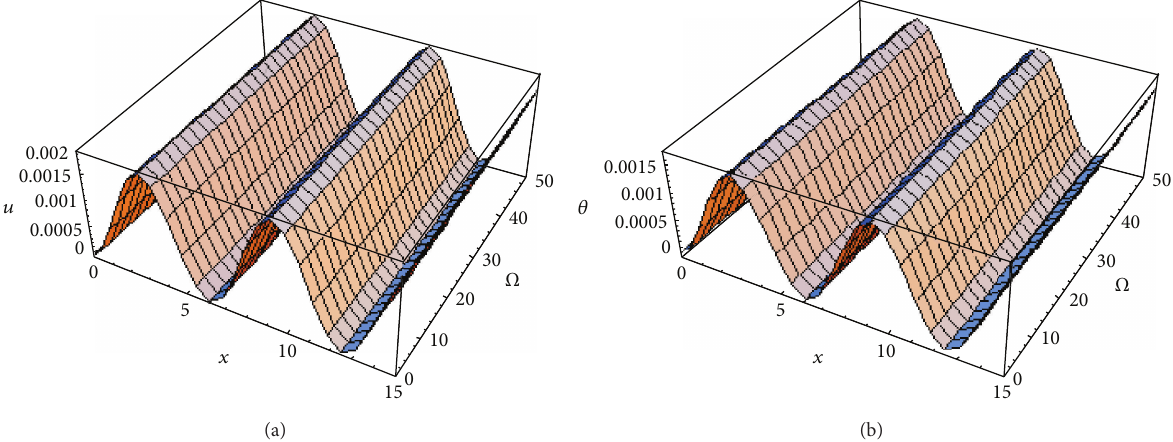
Figure 9: Variations of the displacement 𝑢 and the temperature 𝜃 for various values of the 𝑥 -axis and rotation Ω when 𝜎 1 = 𝜎 2 = 0 , 𝑡 = 0.1 , = 0.2 , 𝜏 = 0.1 , 𝛿 = 0 , and 𝜔 = 0.02 𝜏 2 1